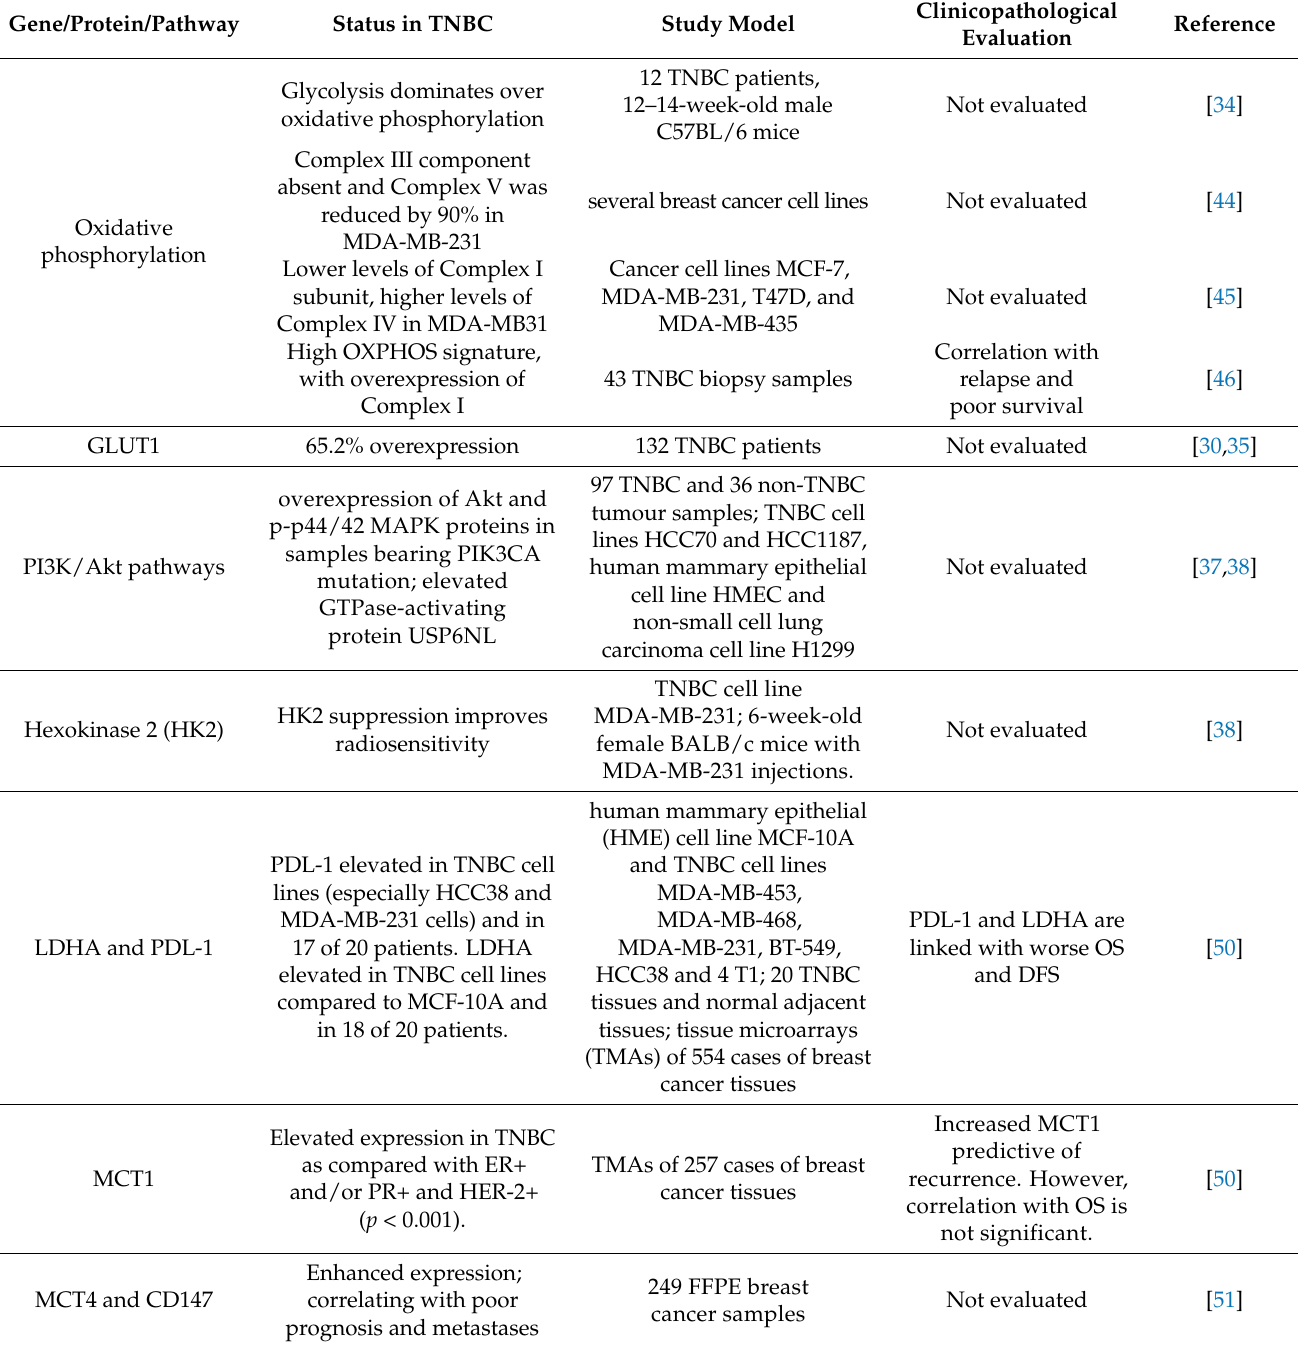
Table 1. Glucose metabolism and glycolysis in